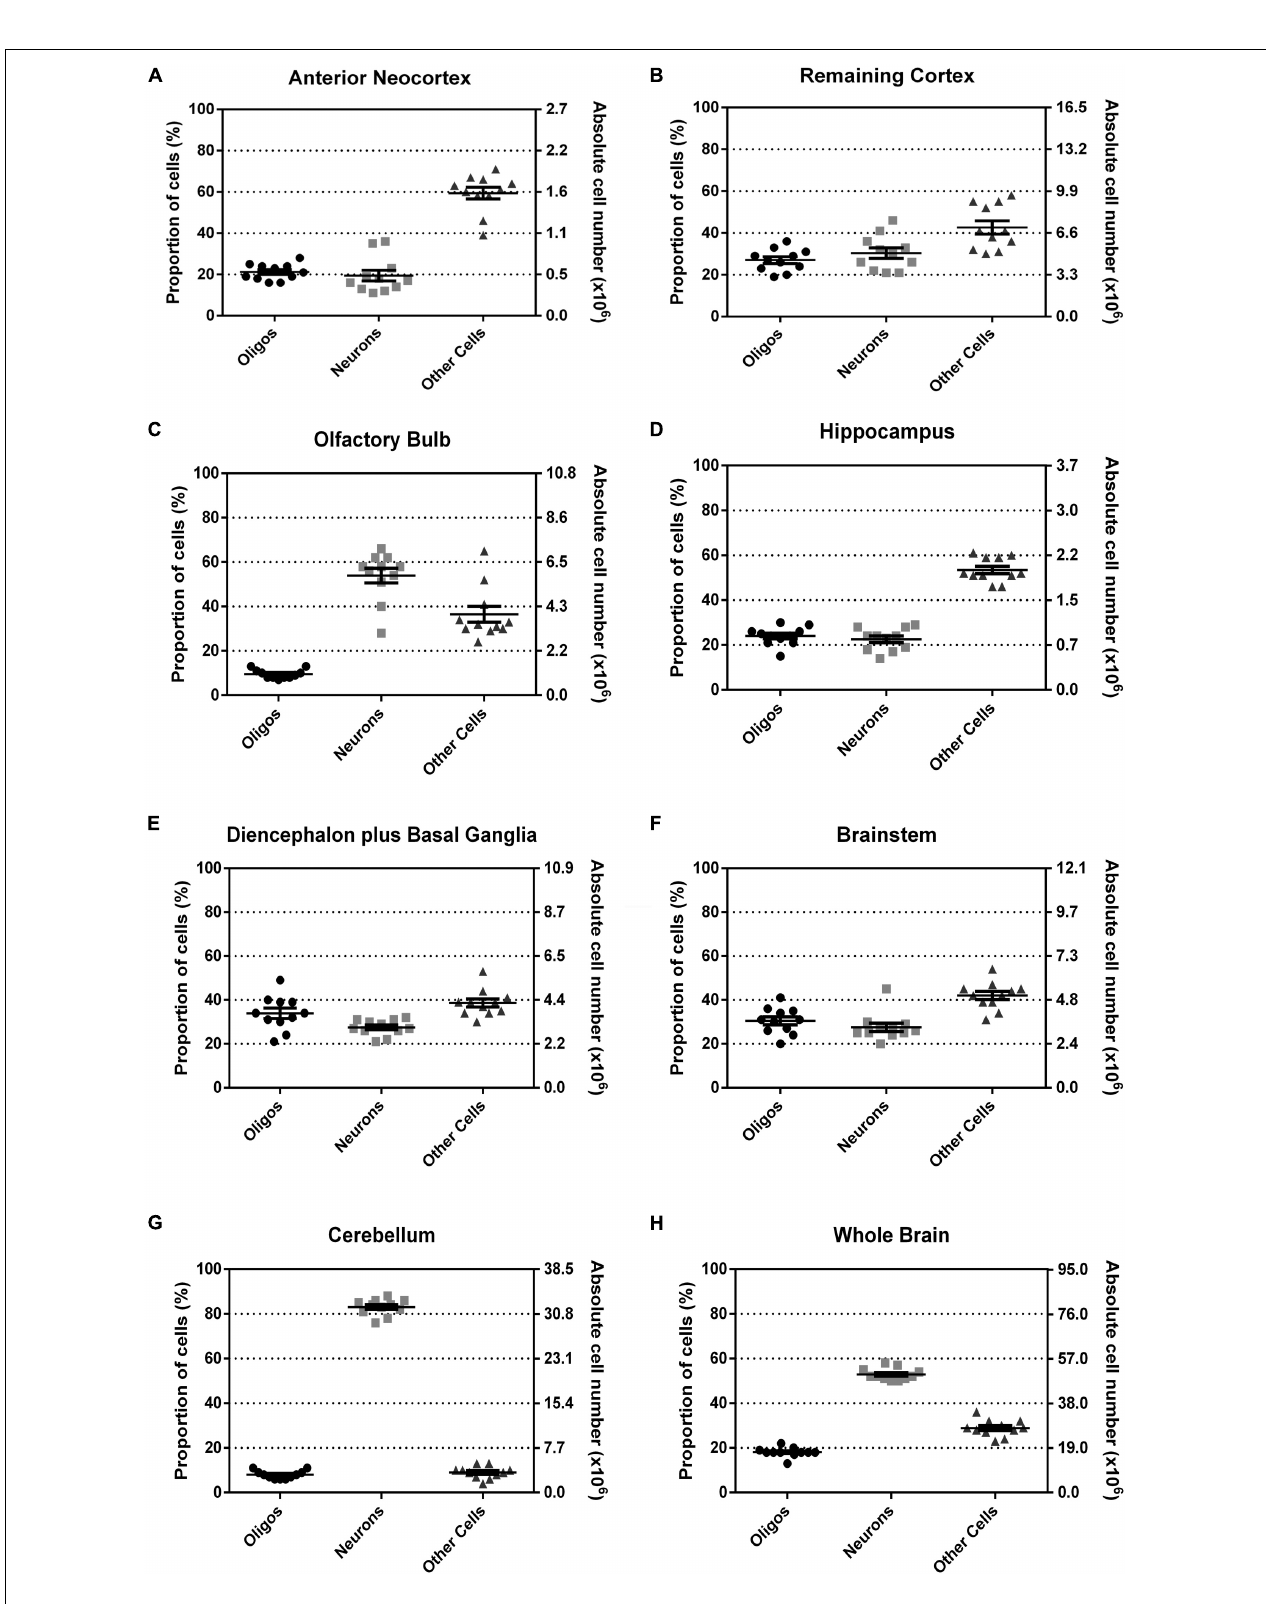
FIGURE 6 | Relative and absolute number of oligodendrocytes, neurons and other cells, in percentage for all the dissected regions (A–G) and for the whole brain (H) . Data shown as scatter-plots, with mean and standard error of the mean, n = 11.